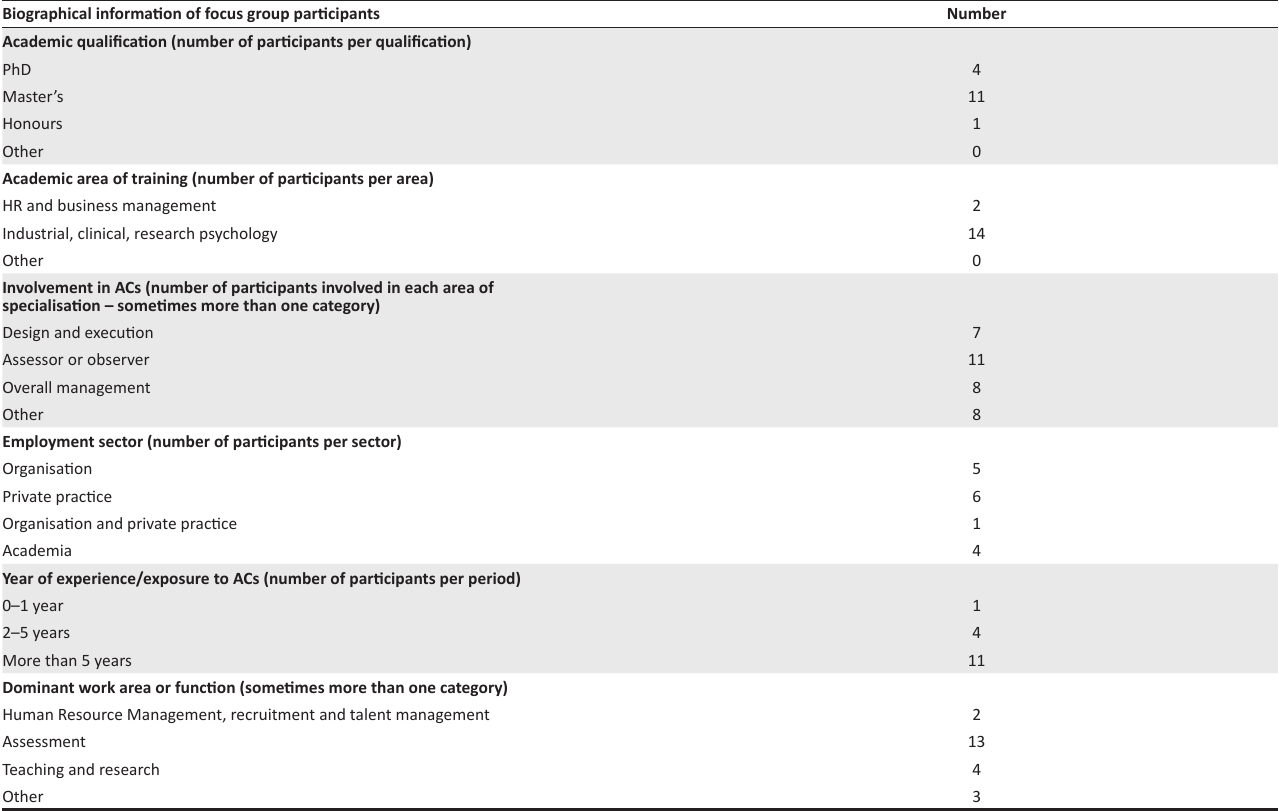
TABLE 1-A2: Biographical information of focus group participants ( n = 16) Biographical information of focus group